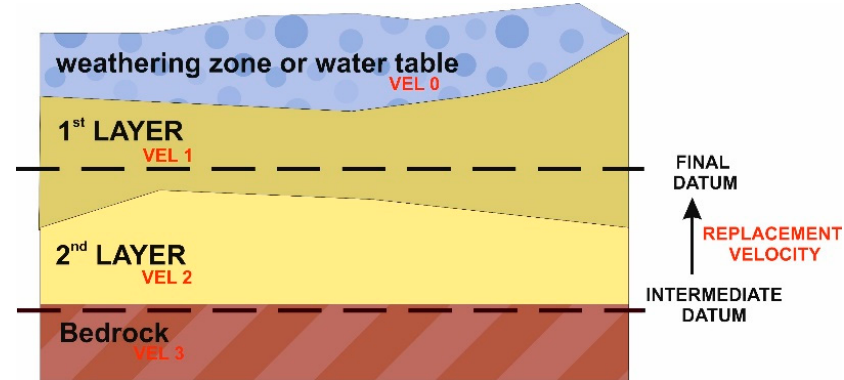
Figure 4. The scheme of the delay time analysis method (DTA) method.